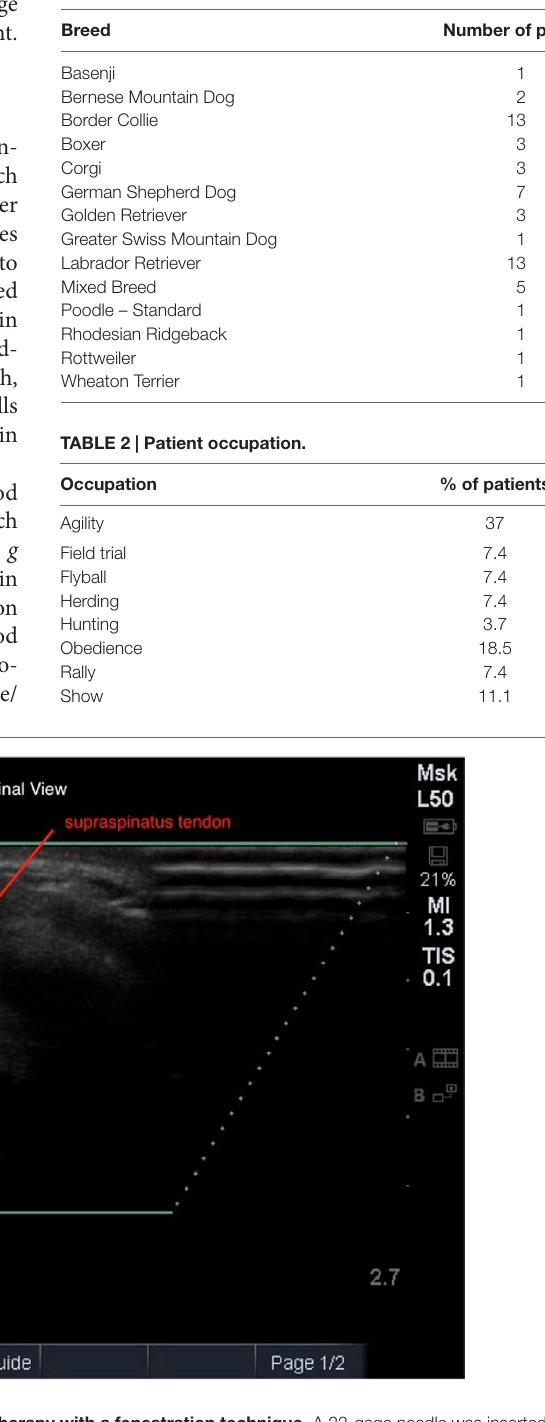
TaBle 1 | Patient breed.